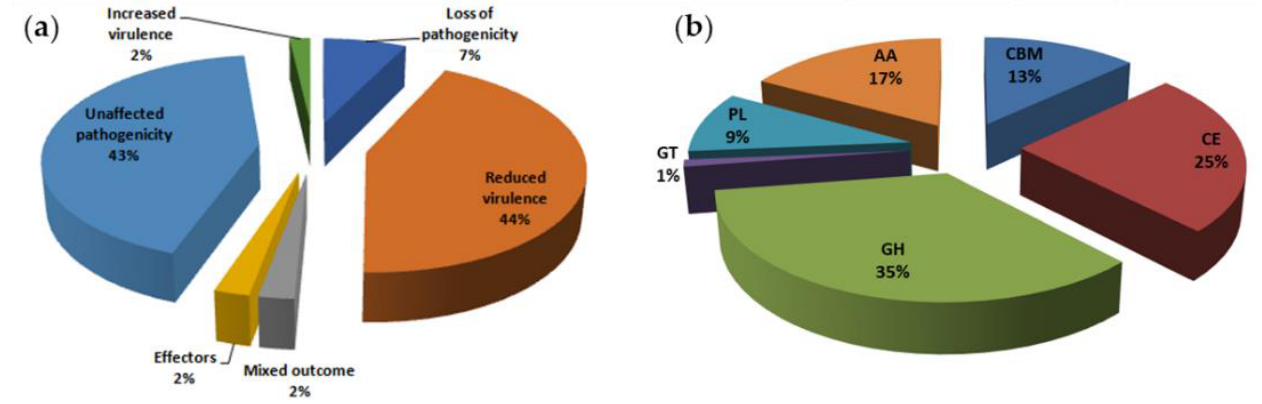
Figure 4. Pathogenic gene analysis of Ci 14017 effector protein. ( a ) PHI-base comparison results of 289 effector proteins. The text in the figure represents the phenotype after deletion of the mutant gene; ( b ) CAZymes classification of 1718 secreted proteins. CBMs: carbohydrate-binding modules, CEs: carbohydrate esterases, GHs: glucoside hydrolases, GTs: glycosyl transferases, PLs: polysac- charide lyases, AAs: auxiliary activities.